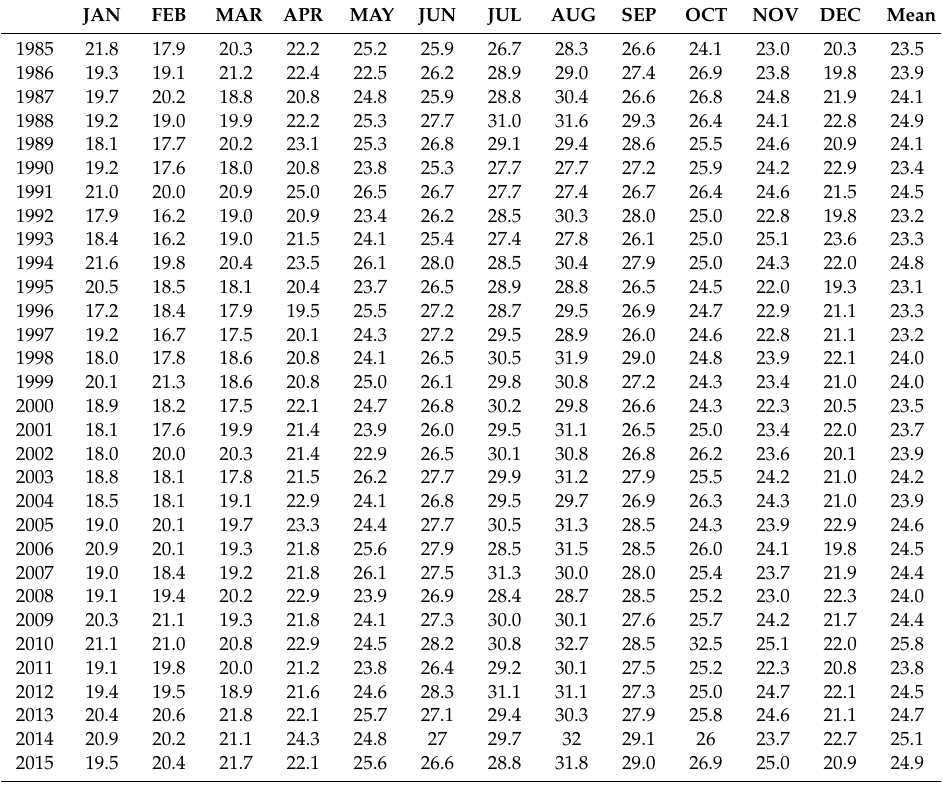
Table A2. Minimum temperature ( ◦ C).